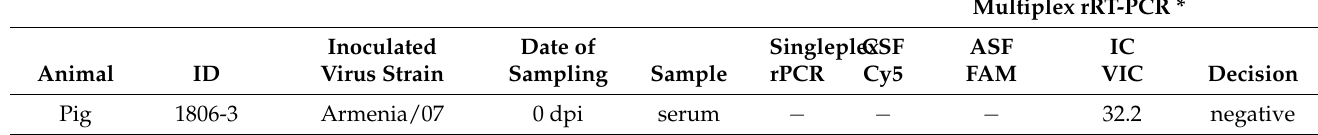
Table 1. Detection of ASFV in samples obtained from pigs and wild boars experimentally infected with ASFV